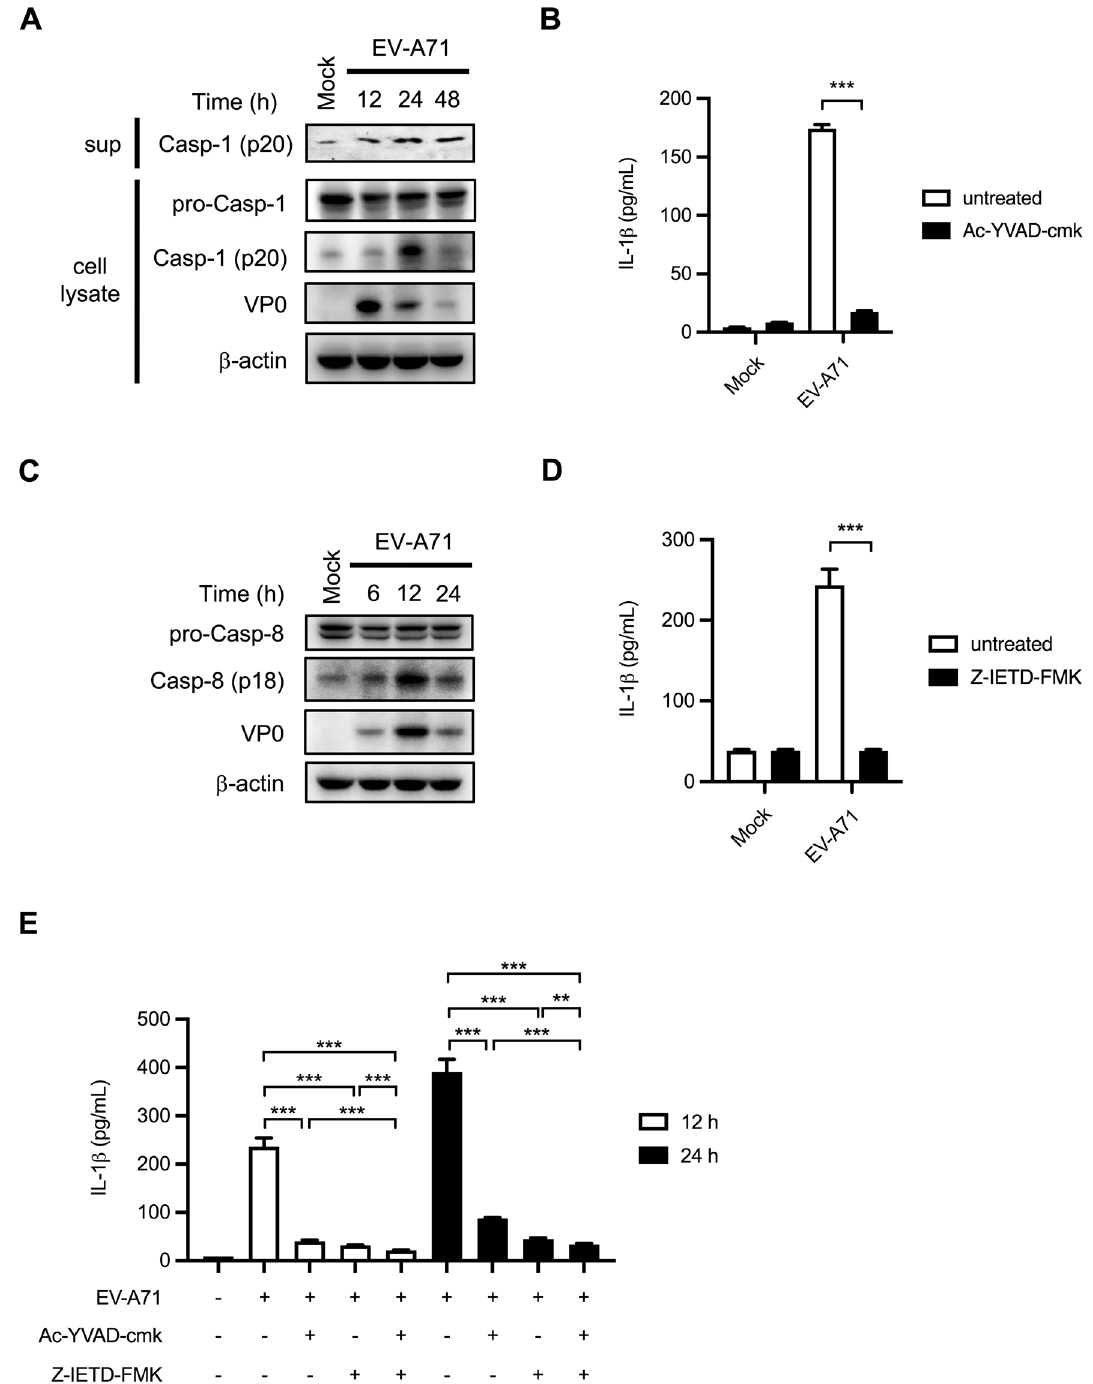
Figure 1. EV-A71 infection induced IL-1β secretion is dependent on caspase-1 and caspase-8. ( A ) PMA- primed THP-1 cells were infected with EV-A71 (2 M.O.I.). The expression levels of cleaved caspase-1, pro- caspase-1 and EV-A71 viral protein VP0 was analyzed by Western blot. β-actin was used as a loading control. ( B ) THP-1 macrophages were treated with the caspase-1 inhibitor (Ac-YVAD-cmk) at the concentration of 1 μM. The cells were then infected with EV-A71 at the M.O.I. of 2 for 12 h. IL-1β levels in the supernatant were determined by ELISA. ( C ) PMA-primed THP-1 cells were infected with EV-A71 at an M.O.I. of 2. Cell lysates were harvested at 6, 12, and 24 h post-infection. Pro-caspase-8, cleaved caspase-8, EV-A71 VP0, and β-actin were determined by Western blot. ( D ) THP-1 macrophages were treated with the caspase-8 inhibitor (Z-IETD-FMK) at the concentration of 20 μM and infected with EV-A71 for 12 h. The secreted IL-1β levels were quantified by ELISA. (E) THP-1 macrophages were treated with Ac-YVAD-cmk, Z-IETD-FMK, or Ac-YVAD- cmk + Z-IETD-FMK after virus absorption. Mature IL-1β levels in the supernatants were determined by ELISA. Data are expressed as mean value ± SD (** p < 0.01, *** p < 0.001, Student’s unpaired